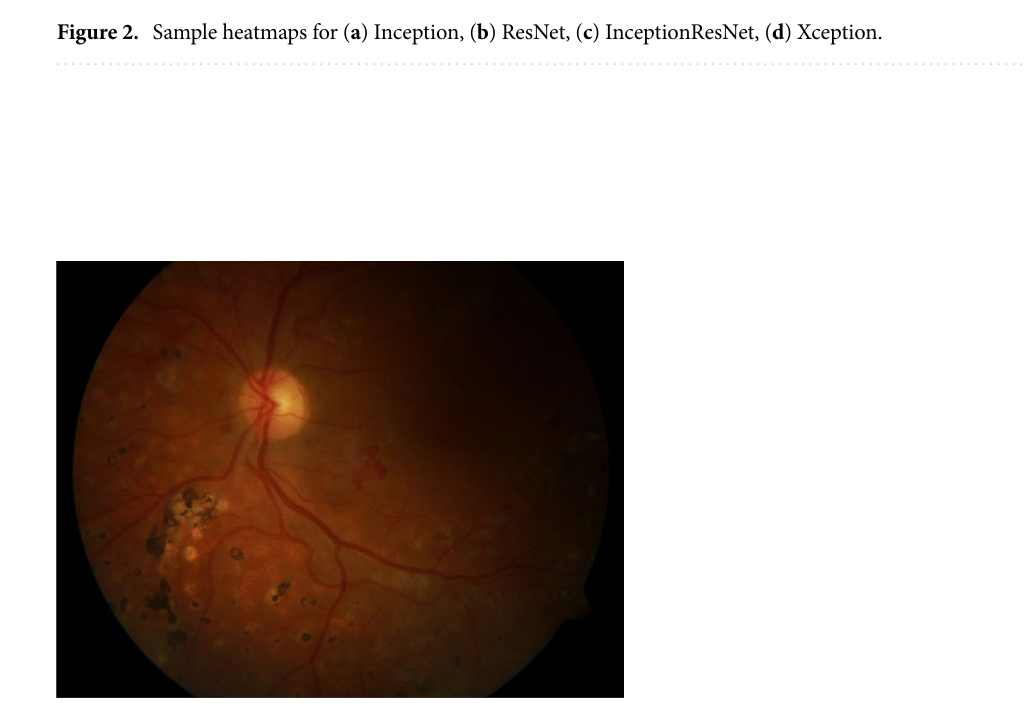
Figure 3. Example fundus image from